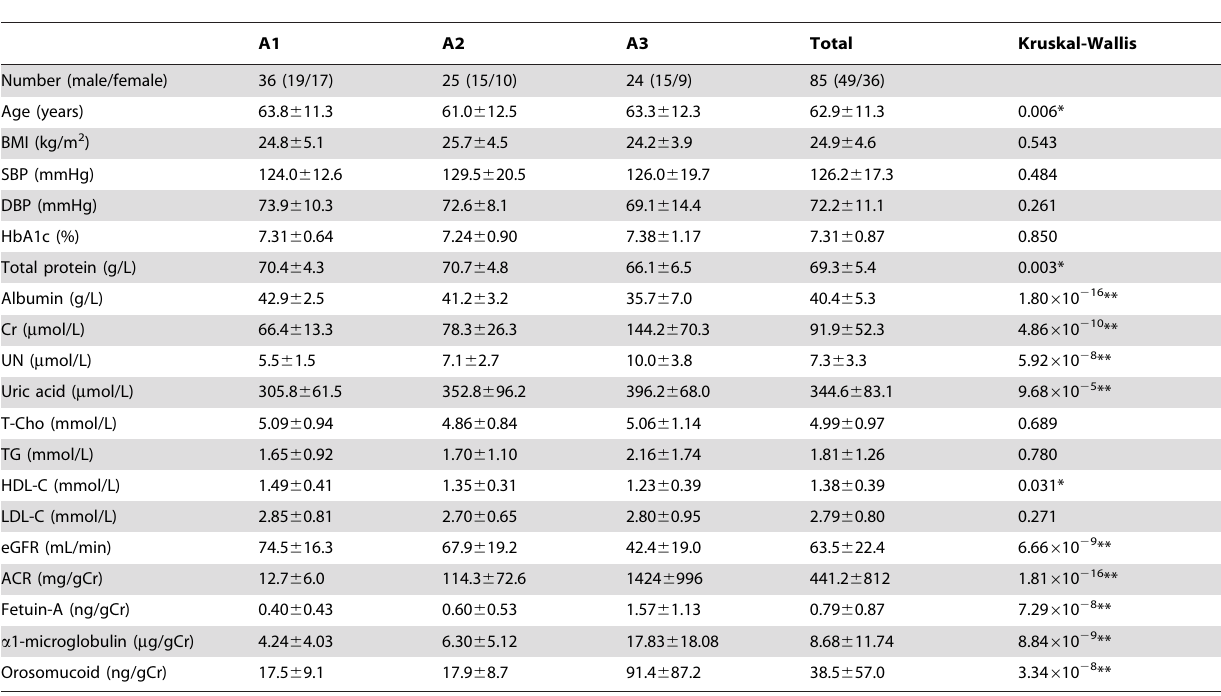
Table 4. Comparison of various parameters in albuminuria stages of chronic kidney disease in type 2 diabetes patients (n